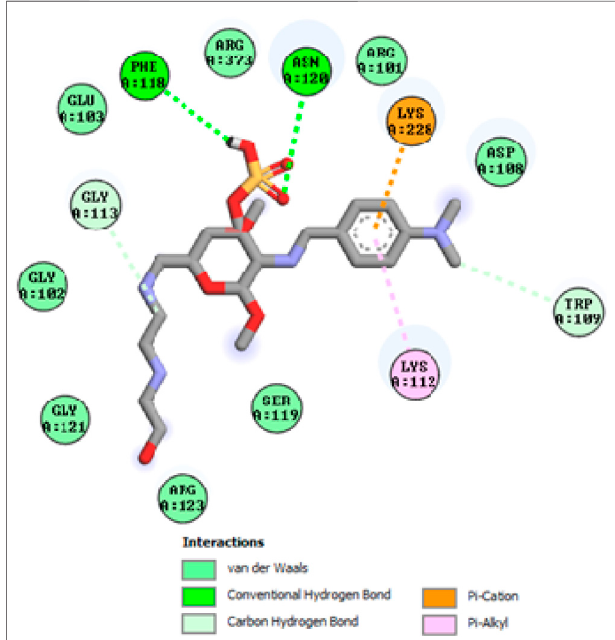
FIGURE 8 | Interaction of compound 2d in the binding pocket of 1Z11 receptor.